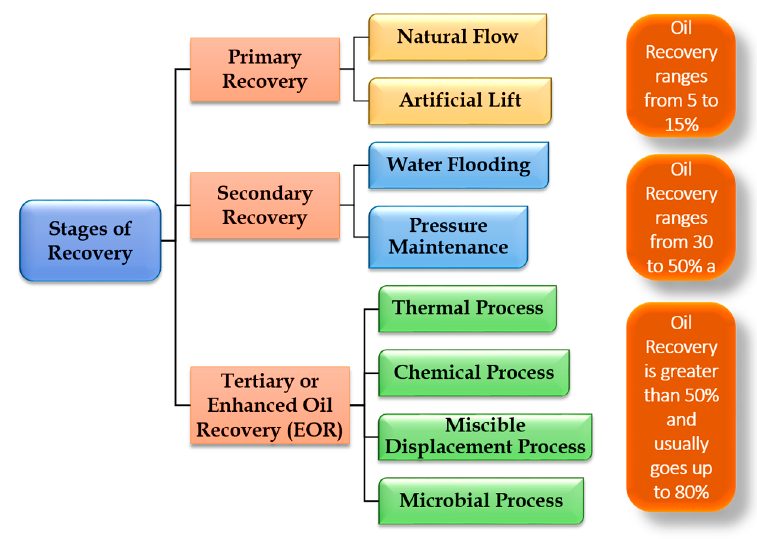
Figure 1. Schematics on the classification of the oil recovery phases.